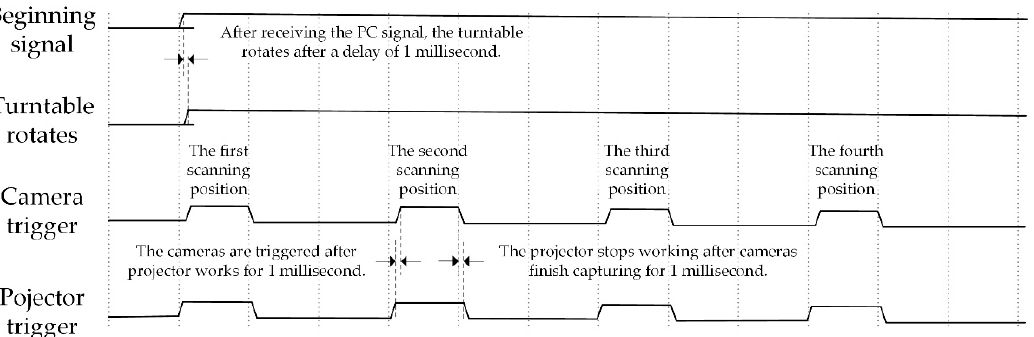
Figure 7. Controlling sequence diagram of the scanning system.